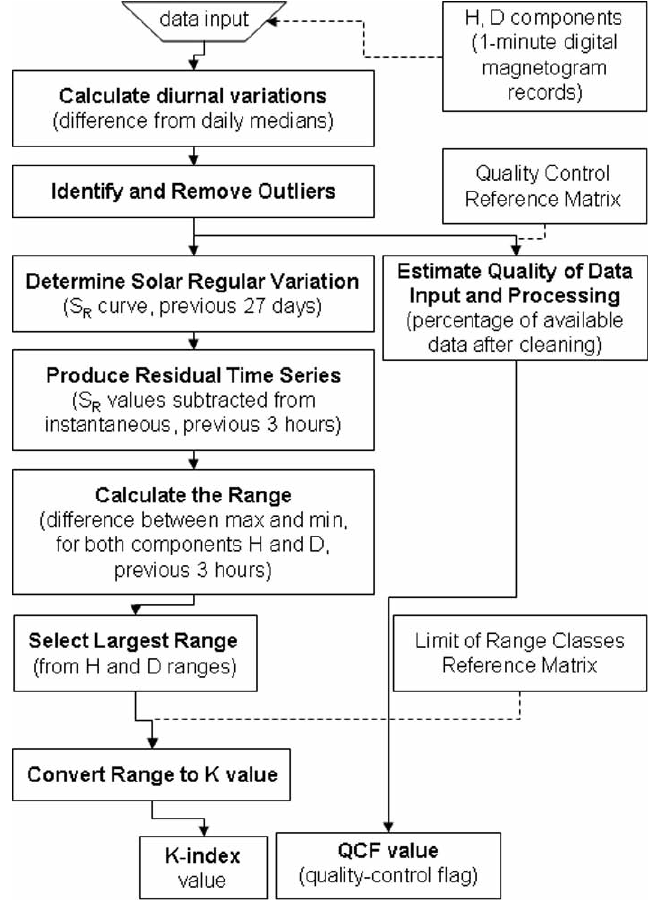
Figure 1. Flow chart of the algorithm for real-time calculation of the K index, with data quality